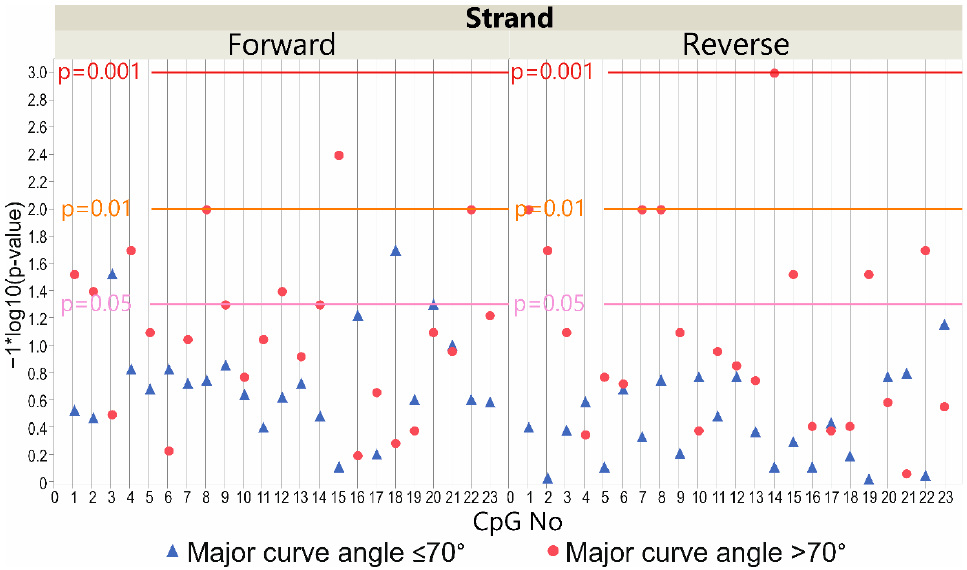
Figure 4. Scatter plot of − log10 p -values showing the difference between methylation level at LBX1 DNA forward strand and DNA reverse strand promoter CpG sites in patients with major curve angle ≤ 70° and >70° (convex vs. concave vs. superficial muscles). Reference horizontal lines represent the p -values.